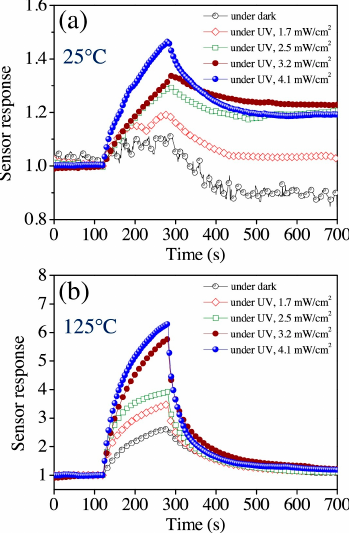
Figure 61. Dynamic 1000 ppm ethanol vapor sensing plots of S06 sensor with different UV illumination intensities operated at operating temperatures of ( a ) 25 °C and ( b ) 125 °C. Reproduced with permission from [88].